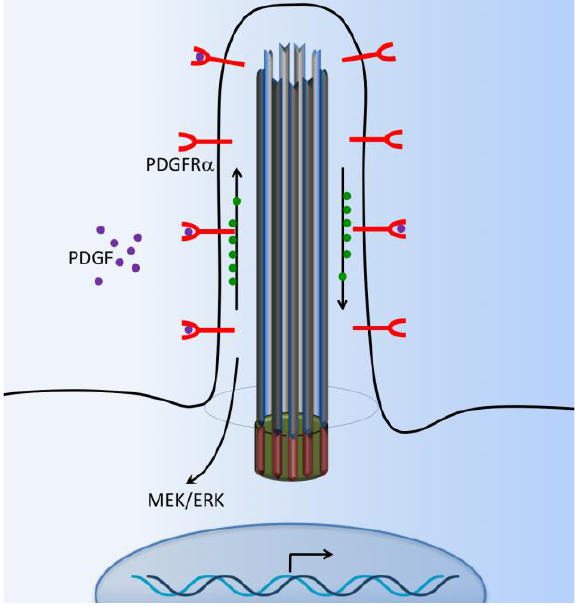
Figure 5. Cilia-dependent PDGFR signaling. The G-protein coupled receptors such as platelet-derived growth factor receptor (PDGFRα) are located at the cilia membrane. The PDGFR pathway is initiated with PDGF ligand binding to their receptors and inducing cellular responses through downstream signaling pathways such as the MEK/ERK cascade.